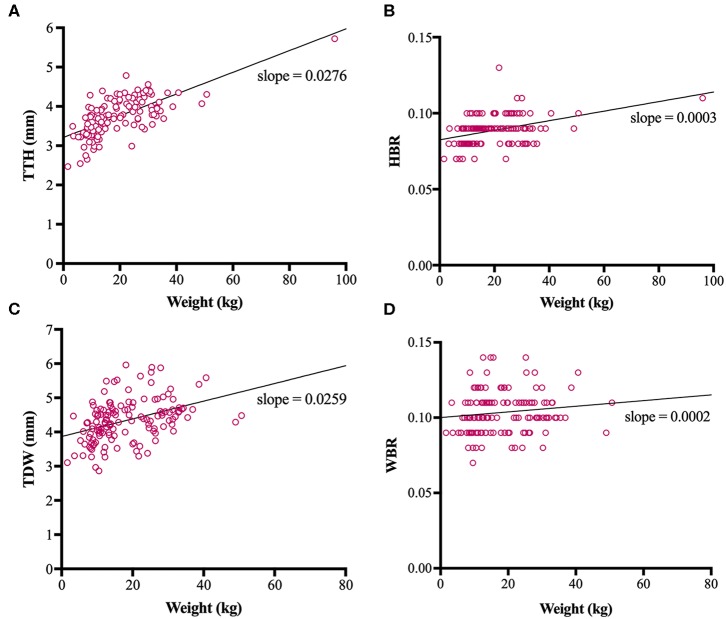
Scatterplots, linear regression lines of best fit and linear regression slopes for trigeminal nerves transverse height (TTH) vs. weight (A), trigeminal nerves height-to-brain ratio (HBR) vs. weight (B), trigeminal nerves dorsal width (TDW) vs. weight (C) and trigeminal nerves width-to-brain ratio (WBR) vs. weight (D).